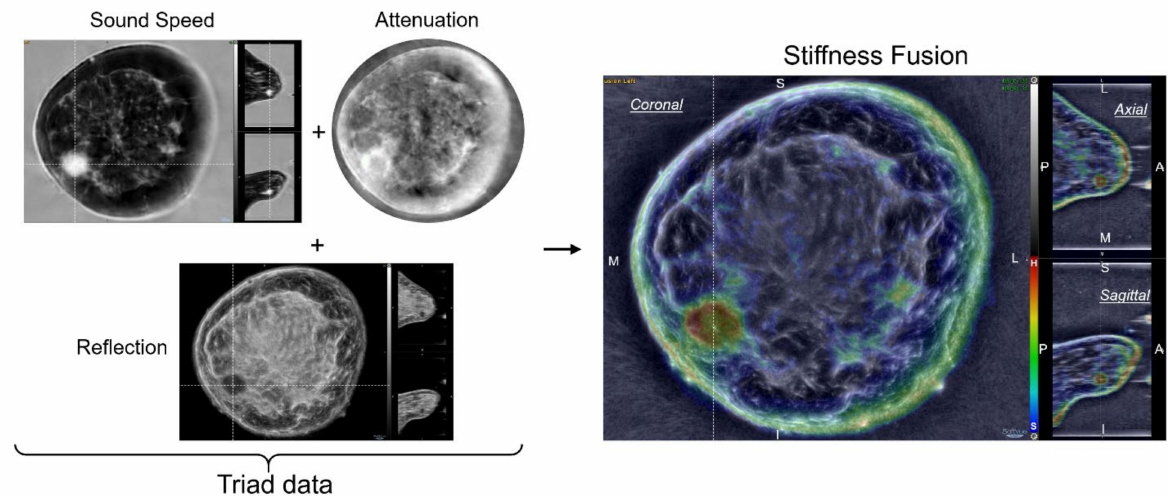
Figure 1. Ultrasound tomography (UST) stiffness imaging is generated from a fusion of a data triad, comprised of quantitative transmission properties from sound speed and attenuation, then overlaid upon co-registered reflection images. Clinical images of a left breast cancer in the 8:00 position (i.e., sound speed, reflection and stiffness fusion) allow further 3D localization by placing the cursor over a suspected mass on the higher resolution coronal images (0.75 mm). The anterior/posterior locations of the stiff cancer (red) can then be viewed in the lower resolution axial and sagittal reconstructions to the right of each coronal image (i.e., 2.5 mm coronal slice thickness). Attenuation is not shown with similar localization since it is only displayed as a component of Stiffness Fusion. Abbreviations: M = medial, L = lateral, S = superior, I = inferior, P = posterior, A = anterior; color scale denotes red as hard (H) and blue as soft